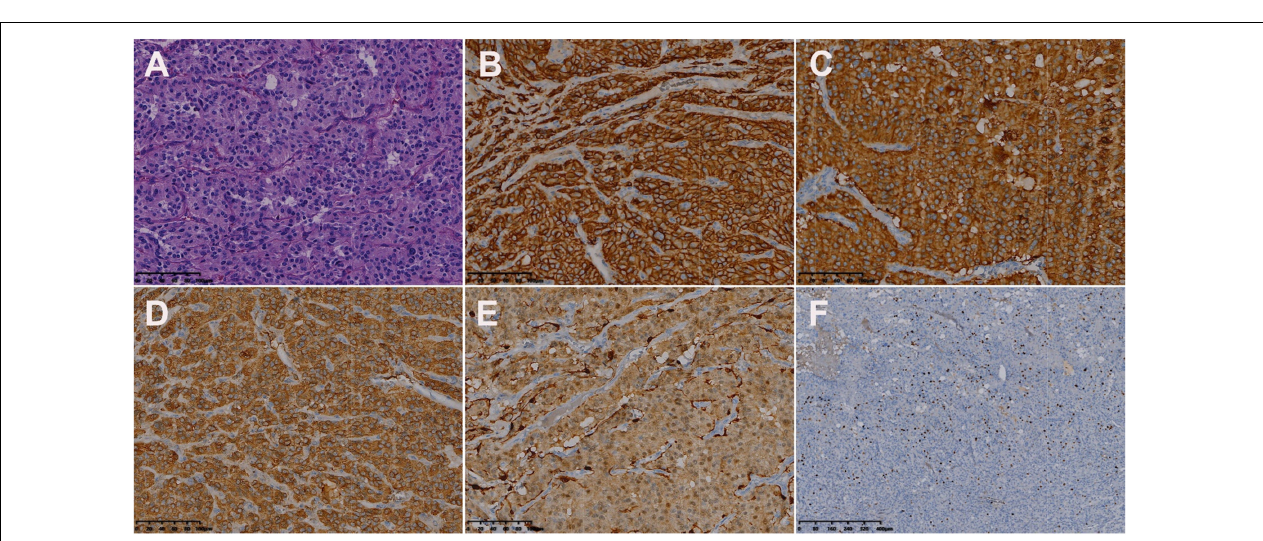
FIGURE 5 | Histologic and immunohistochemical features of cardiac paraganglioma. (A) Hematoxylin-eosin (HE) staining showed that the tumor cells were polygonal, with round-like nuclei and rare nuclear fission images (magnification, × 200). In immunohistochemical staining, the tumor cells were positive for CD56 (B) , SYN (C) , CgA (D) , and S-100 (E) . Moreover, 3% of them were positive for Ki-67 (F) [magnification (B–F) × 200].